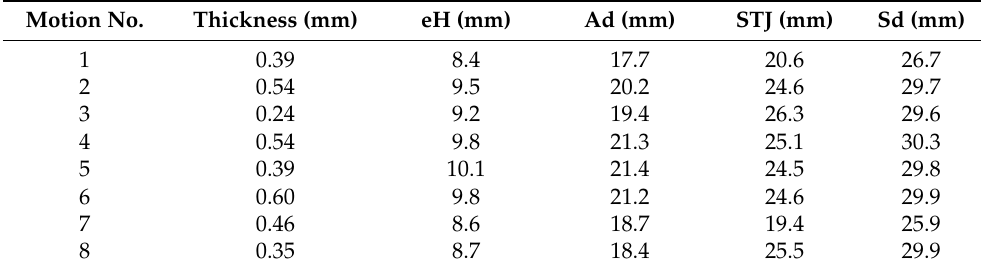
Table 8. Geometric parameters of aortic valves with eight motions in the test dataset. Motion